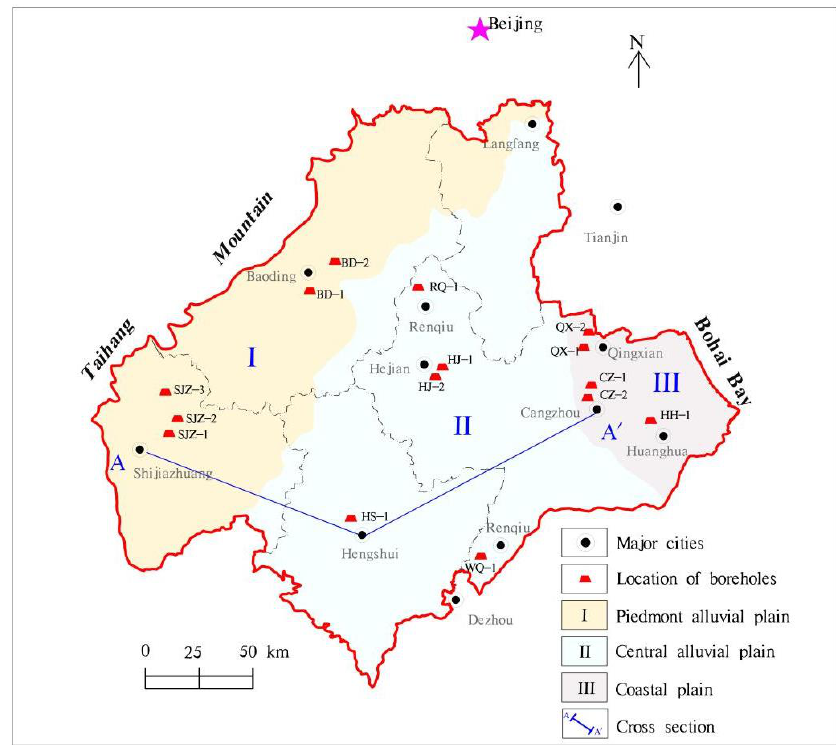
Figure 1. Map of the central North China Plain. General features of the representative regions are shown in Table 1. For the piedmont alluvial plain, the Quaternary sediments within 200 m are dominated by sand, gravel, and clay with great inhomogeneity [36]. The Quaternary aquifer is unconfined and is recharged by infiltration of atmospheric precipitation and lateral flow from mountains. With a relatively high hydraulic conductivity and high specific yield, groundwater flow velocity in this region ranges between 0.013 and 0.26 m/d [36] and the water table depth ranges between 20 and 45 m [37]. The cities of BD and SJZ are representative cities of this